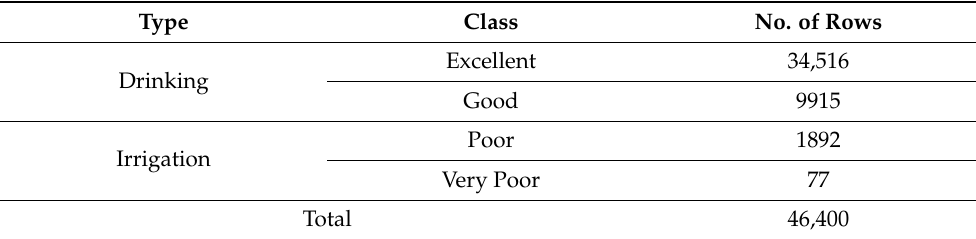
Table 1. The statistics of the GEOTHERM